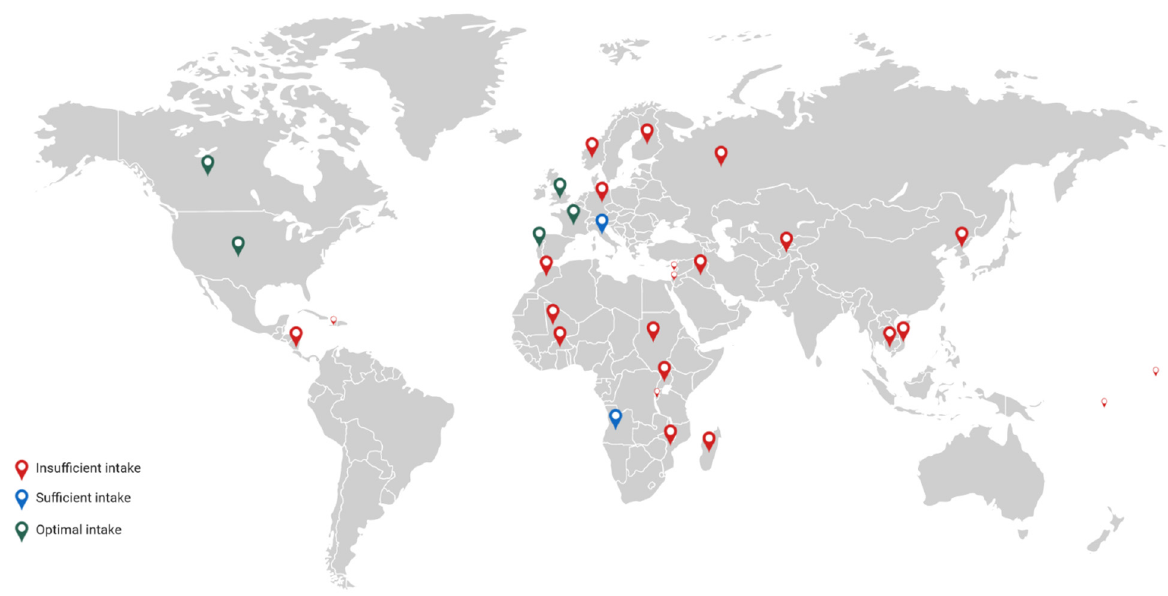
Figure 2. Insufficient iodine intake is observed in many regions, mainly African and Asian countries. Optimal intake of iodine occurs among other in the United States, Canada, and some countries in Europe. However, intake of iodine is not adequate in many European regions.